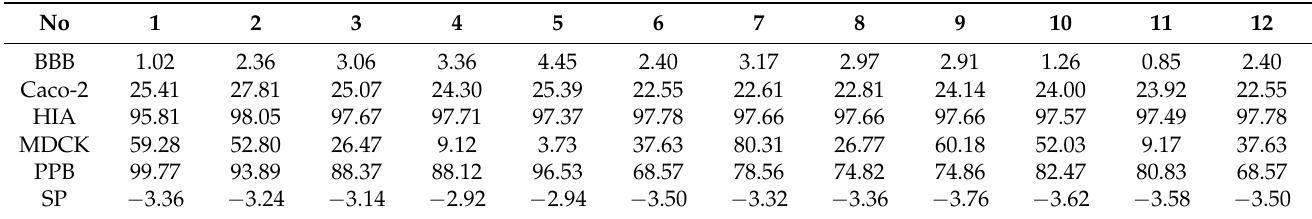
Table 6. The ADME activities predicted for 1,9-dipyridothiazines 1 – 11 and prothipendyl 12 [24] .